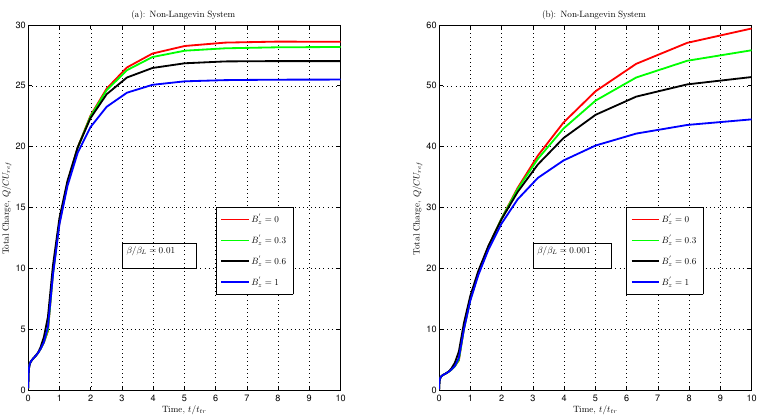
Figure 5. Total charge as a function of normalised time with varying magnetic fields for